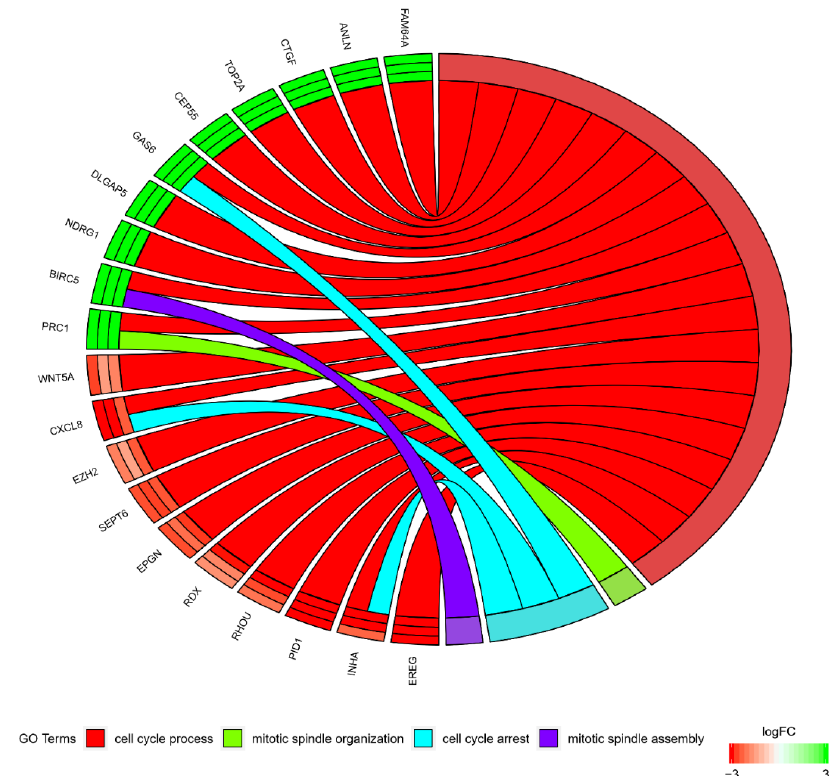
Figure 3. A representation of the mutual relationship between the 20 chosen genes that belonged to the “ cell cycle arrest ” , “cell cycle process”, “ mitotic spindle assembly checkpoint ” , “ mitotic spindle assembly ” , “ mitotic spindle checkpoint ” , and “ mitotic spindle organization ” GO BP terms. The ribbons indicate which gene belongs to which category. The colors of the three inner bars near each gene correspond to the logFC after 7, 15, and 30 days. The genes were sorted by logFC.